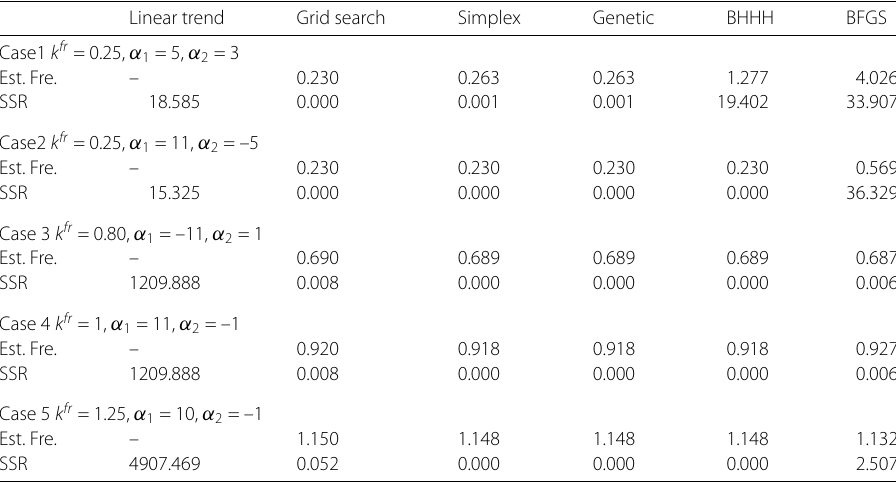
Table 3 Estimated frequencies with different optimization algorithms Linear trend Grid search Simplex Genetic BHHH BFGS